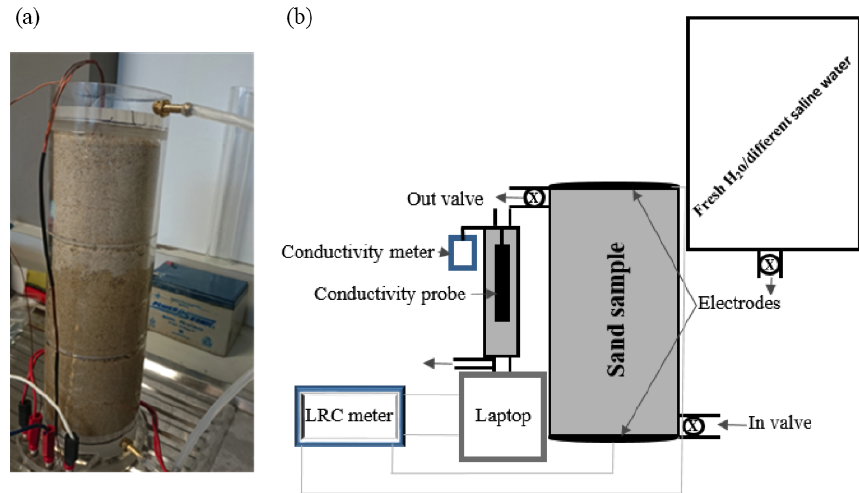
Figure 1. Photo (a) and schematic drawing (b) of the experimental set-up for the flow cell.